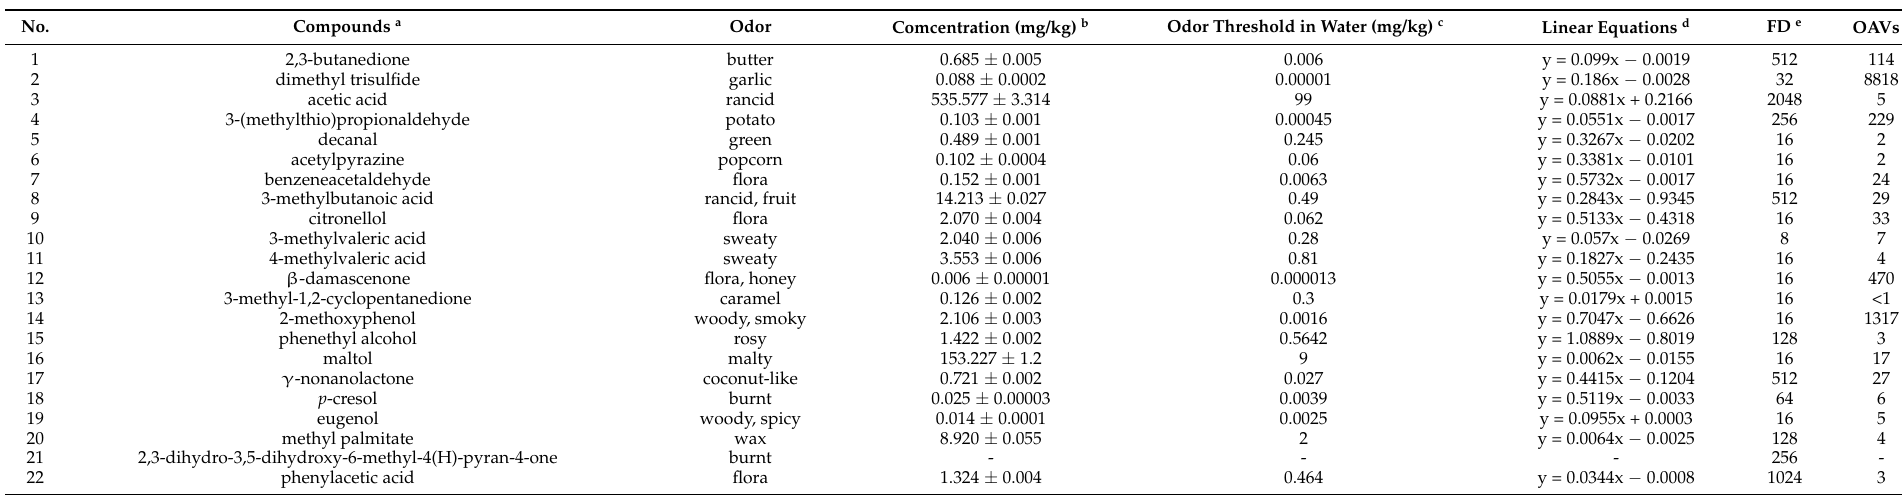
Table 2. Concentrations, odor thresholds, FD factors and OAVs of 21 key aroma-active compounds in Yongchuan